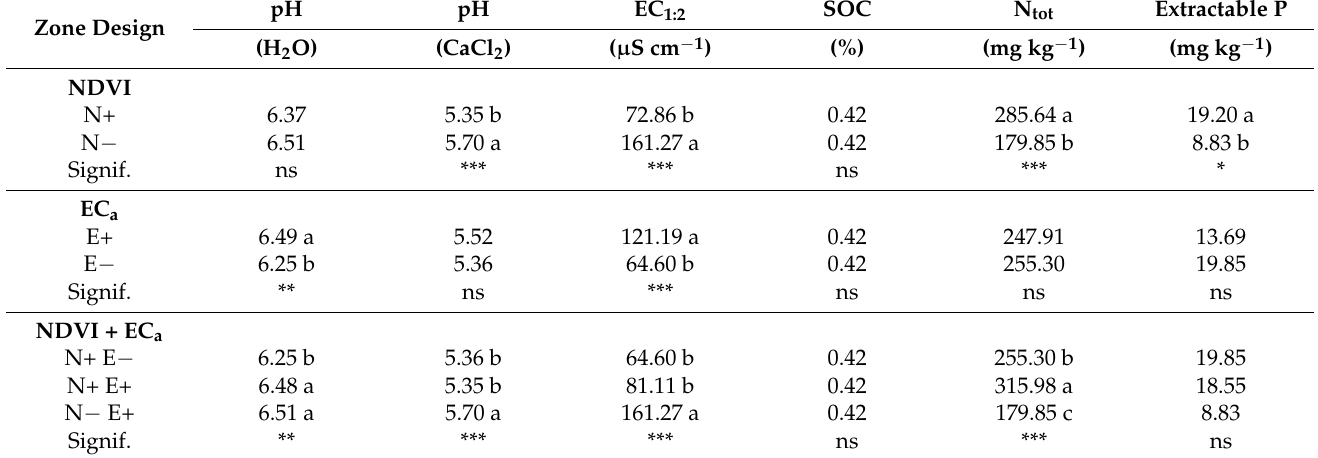
Table 2. Mean values of soil pH (extracted with H 2 O and CaCl 2 ), electrical conductivity (1:2 soil:water extraction), soil organic carbon (SOC), total nitrogen (N tot ), and extractable phosphorus (P) according to zone and indicator